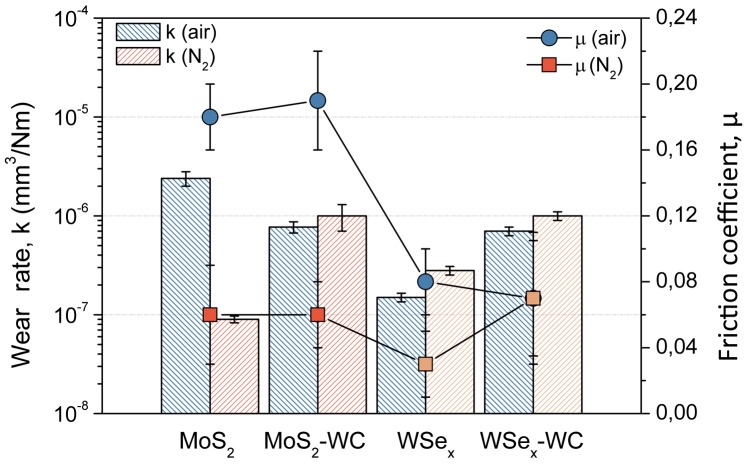
Tribological properties (mean friction coefficient and wear resistance) in ambient air (30–40% RH) and dry nitrogen (<7%) for the MoS2 and WSe2-based coatings.